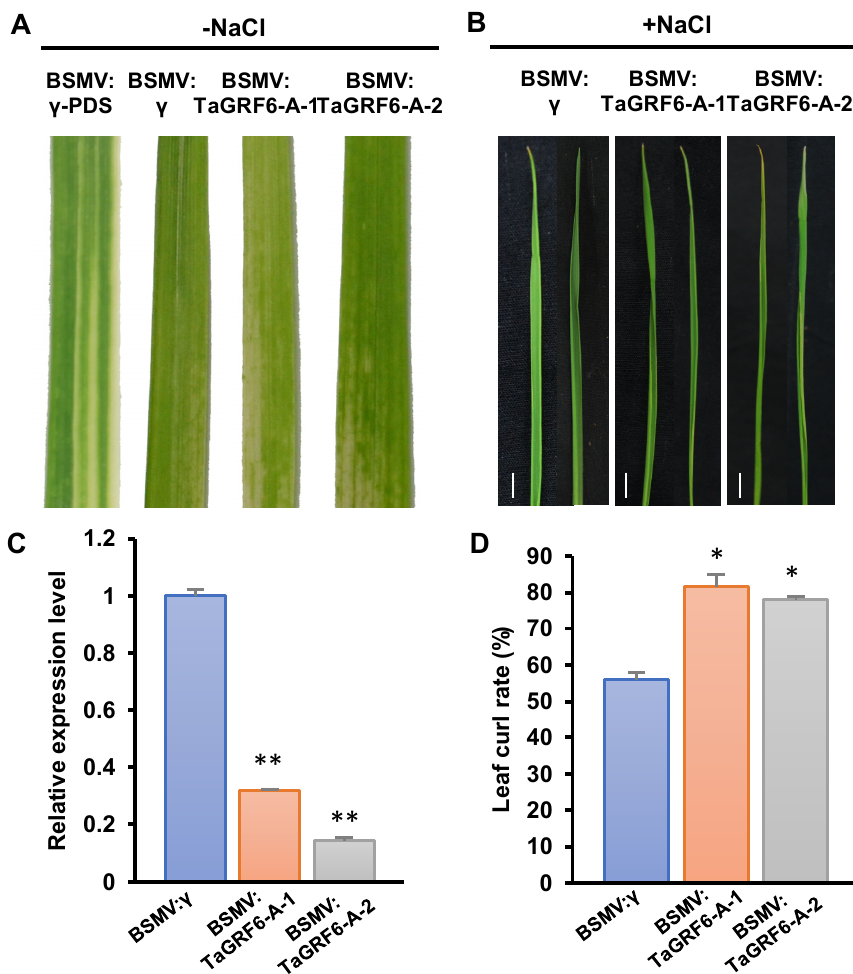
Figure 5. The silencing of TaGRF6-A decreases salt tolerance in wheat. ( A ) Phenotypic characteristics of wheat leaves after TaGRF6-A silenced by VIGS technology. ( B ) The curling phenotype of wheat leaves after 12 days of 300 mM NaCl treatment. Bars, 1 cm. ( C ) Silencing efficiency assessment of TaGRF6-A in the TaGRF6-A -knockdown plants treated with 12 days of 300 mM NaCl. ( D ) Statistics of leaf curls rate of TaGRF6-A in the TaGRF6-A -knockdown plants treated with 12 days of 300 mM NaCl. Error bars represent the SD of three biological replicates. The asterisks indicate statistical significance using Student’s t -tests. ( **, p < 0.01 ; *, p < 0.05).